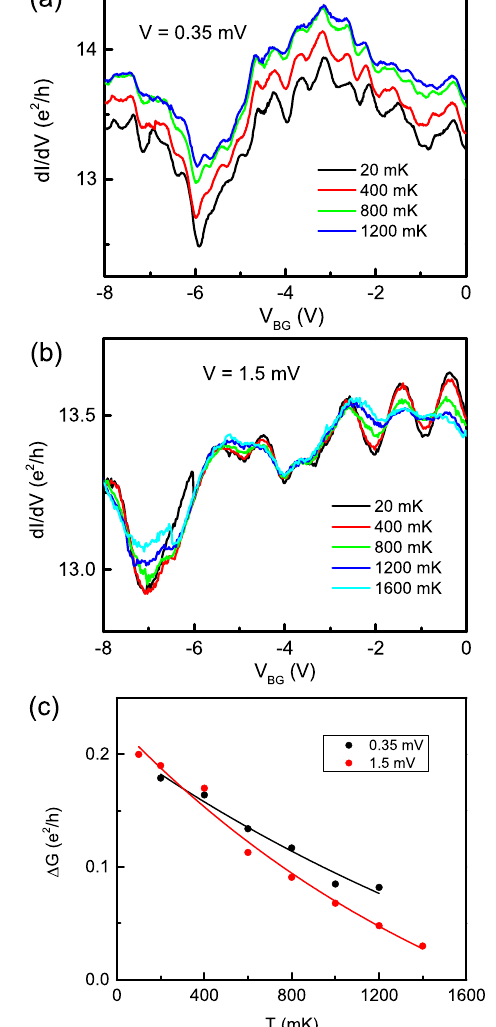
mV.FIG. 4. Temperature dependence of geometric resonances for source-drain bias (a) V ¼ 0 . 35 mV and (b) V ¼ 1 . 5 mV. (c) Peak-to-peak amplitude Δ G of geometric resonances versus temperature (circles) for two different source-drain biases, accompanied by exponential fits (solid